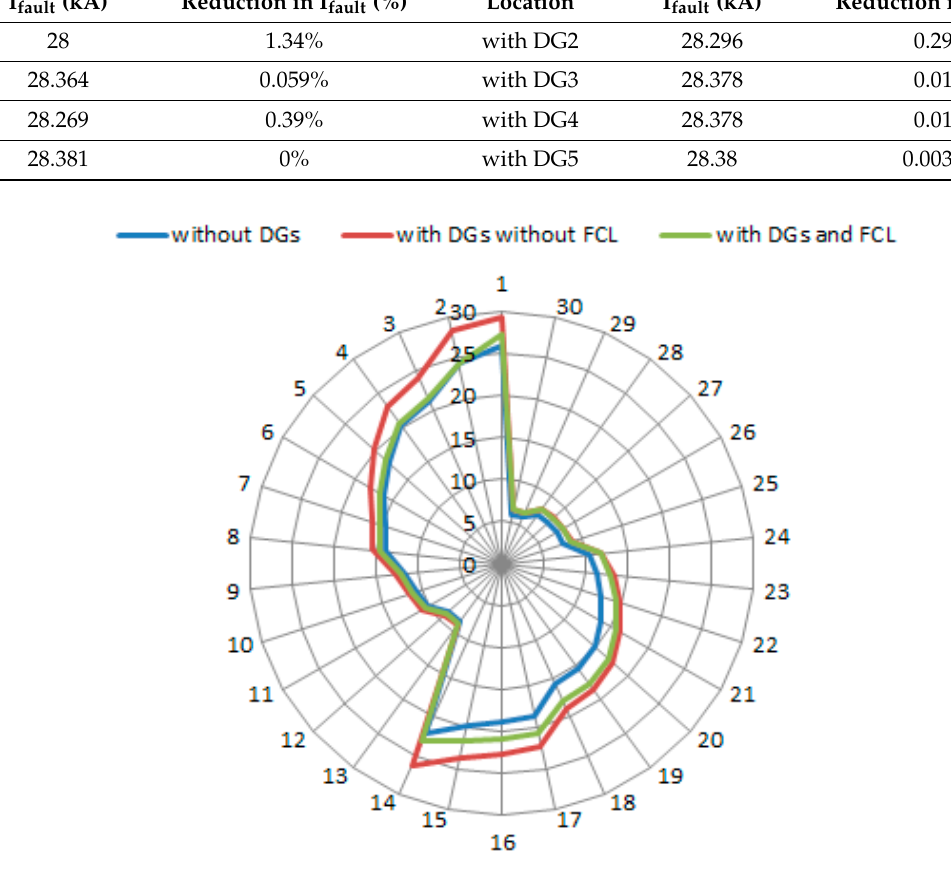
Figure 25. Fault currents at buses with and without FCL .